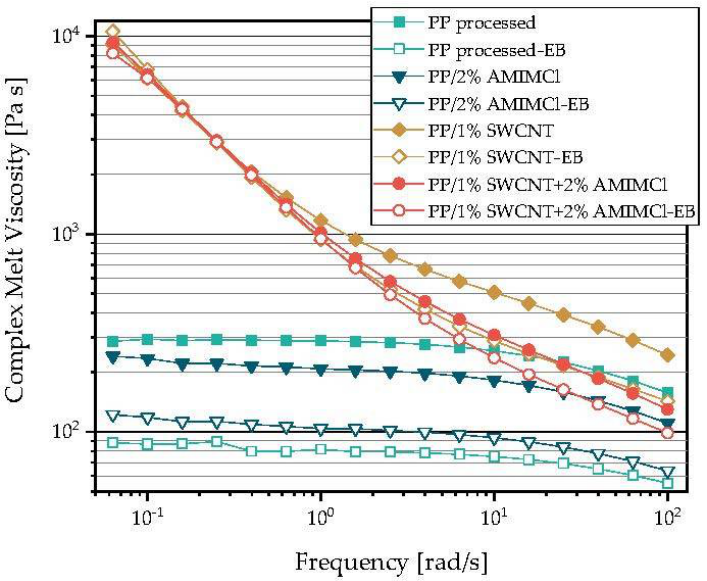
Figure 6. Complex melt viscosity (at 210 °C) of unfilled PP, PP/IL, PP/SWCNT and PP/SWCNT/IL composites before (filled) and after (empty) electron beam irradiation (18 kGy).